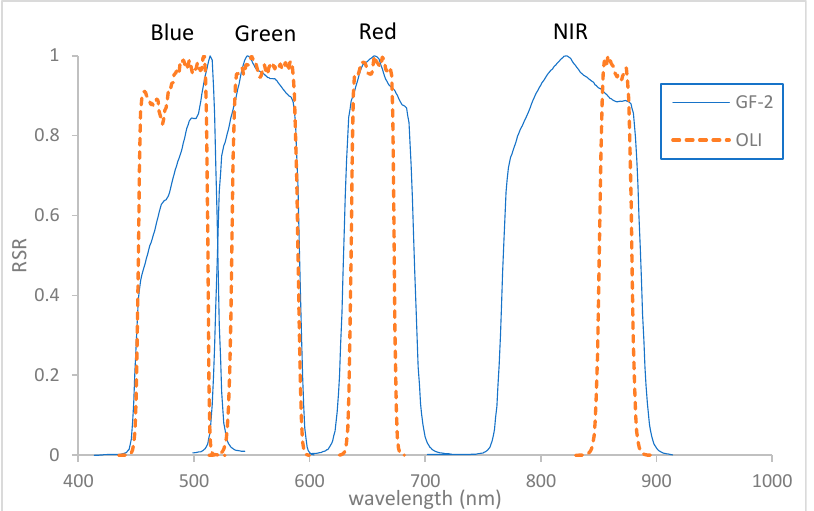
Figure 7. Relative spectral responses (RSRs) of GF-2 and Landsat-8 OLI sensors for similar bands. Table 6. Coefficients of the linear regression bandpass adjustment (OLI = slope * GF2+ offset) and the mean